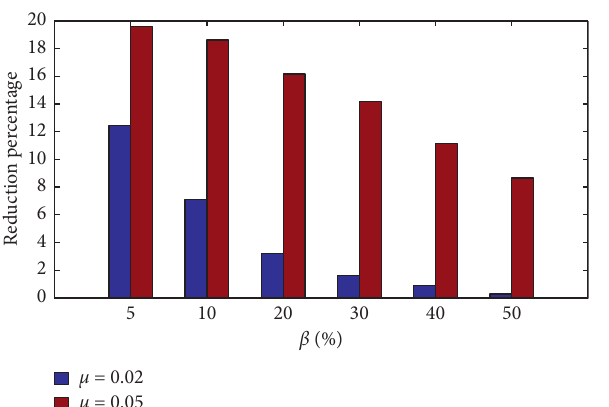
Figure 15: Comparison of the reduction of the peak interstorey drift of the structure subjected to “ Algarrobo ” acceleration record for TMDI designed with µ � 2% and µ � 5% using the J P optimi- zation alternative.